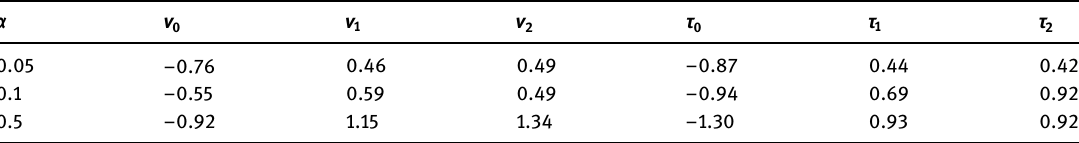
Table 2: Regression coe ffi cients in the data generating model ( 22 )